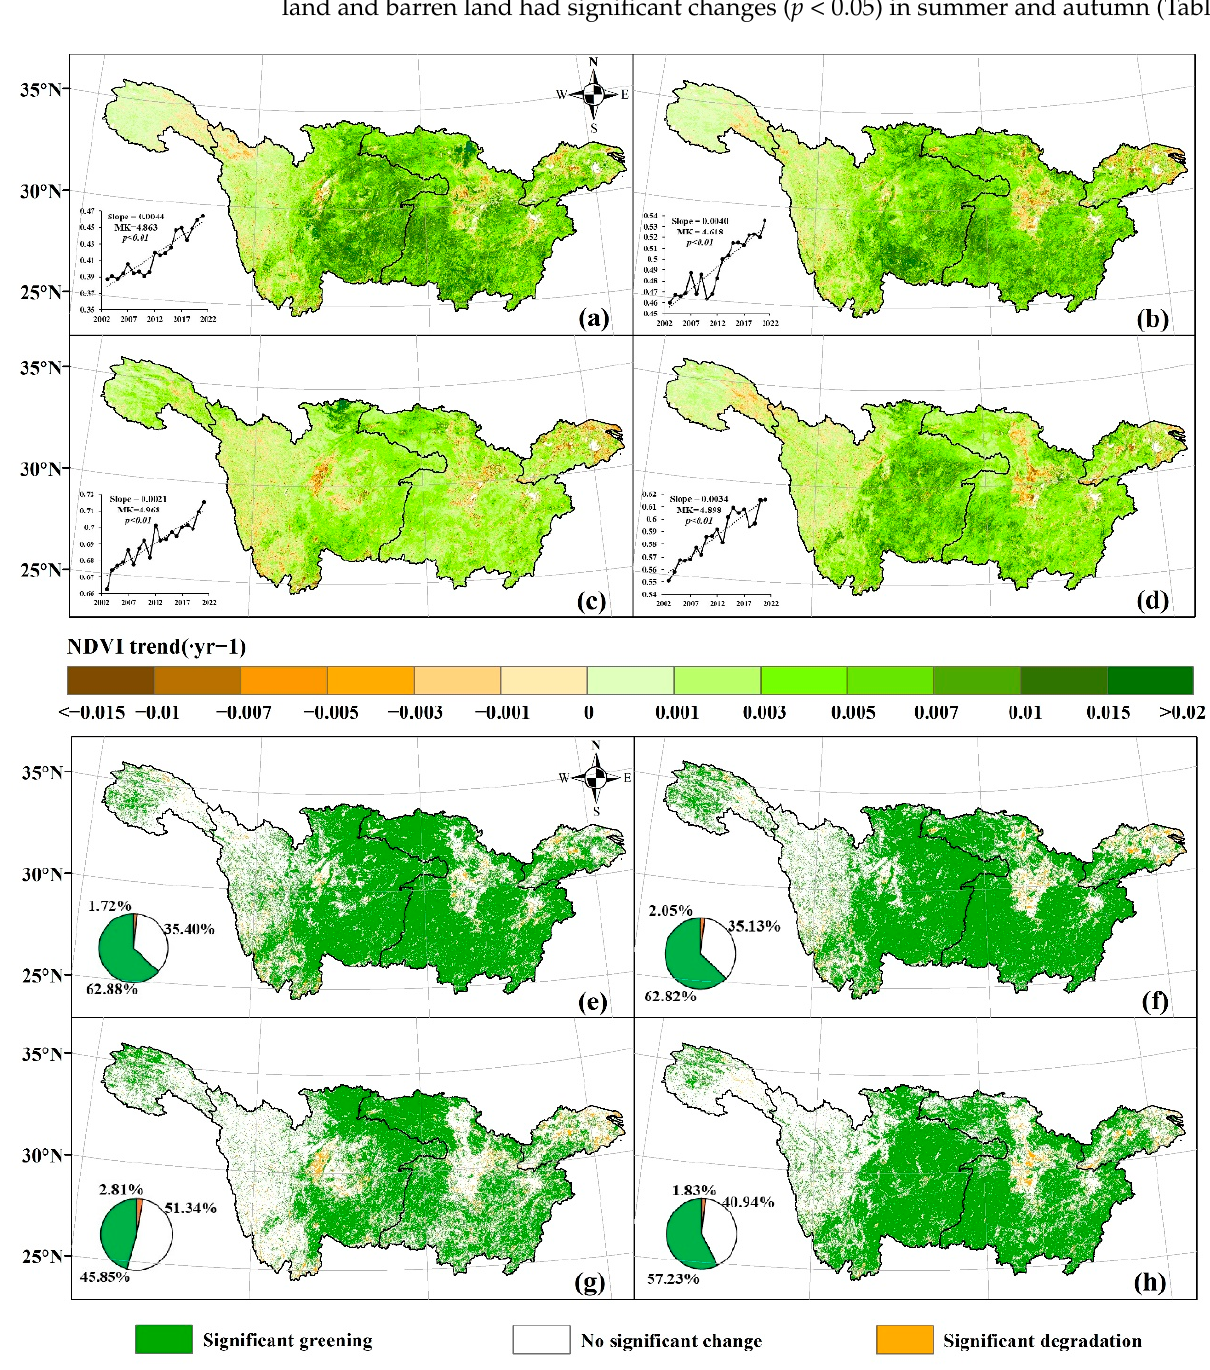
Figure 7. Trend variation and its significance of NDVI from 2003 to 2021 in winter ( a , e ); spring ( b , f ); summer ( c , g ); and autumn ( d , h ). The inset pie charts show the percentage of area with a significant uptrend, significant downtrend and insignificant change, respectively ( e – h ).